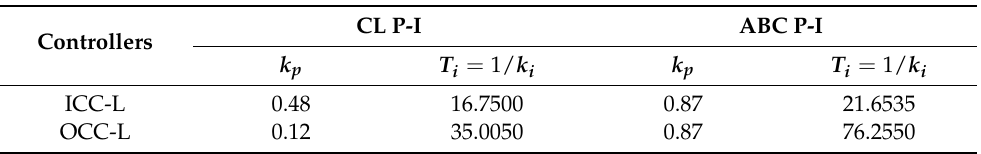
Table 2. P-I controller’s parameters achieved by ABC and classical optimization method for ICC-L and OCC-L.